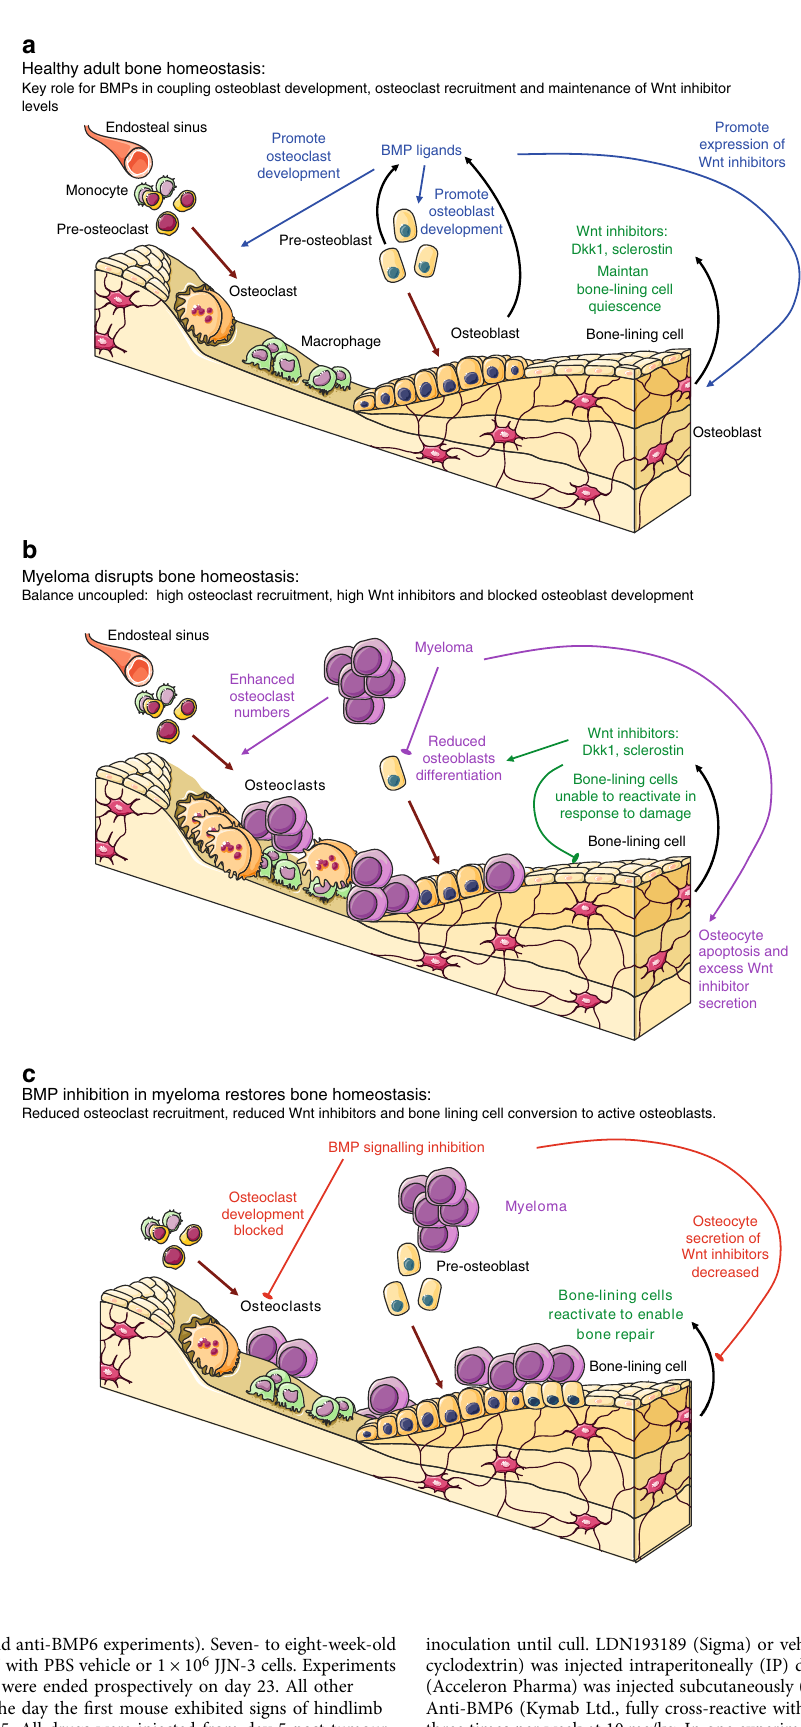
for bone-lining niche sorting were ended prospectively on day 23. All other experiments were ended on the day the fi rst mouse exhibited signs of hindlimb weakness, typically days 21 – 25. All drugs were injected from day 5 post tumour three times per week at 10 mg/kg. In one experimental replicate using